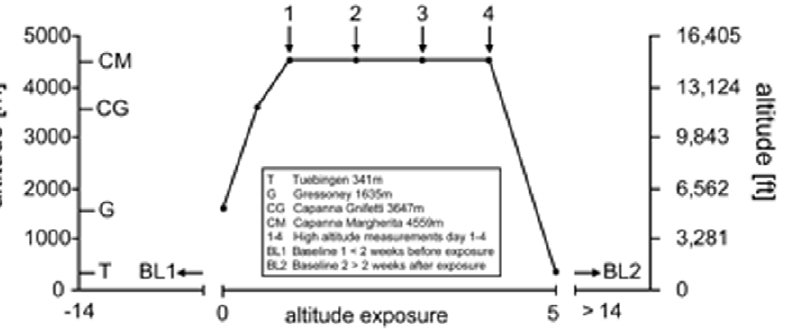
Figure 1. Ascent profile to the Capanna Margherita (4559 m). Ascent profile of participants to the Capanna Margherita (4559 m). Numbers indicate the four HRT3 H measurements performed at high altitude.